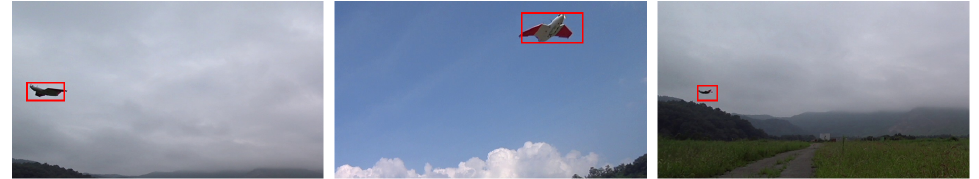
Figure 7. Qualitative results of UAVs with relatively medium or large size. Red boxes denote visual tracking results of the proposed